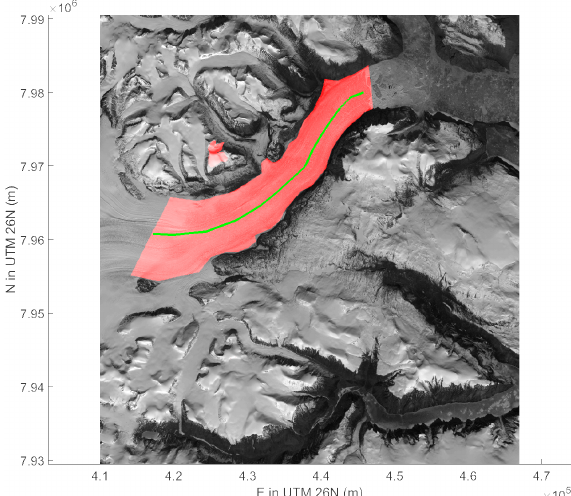
Figure 7: Centerline (green) and areas (red) considered for the quantitative analysis, overlaying the SPIRIT 2014 orthoimage.